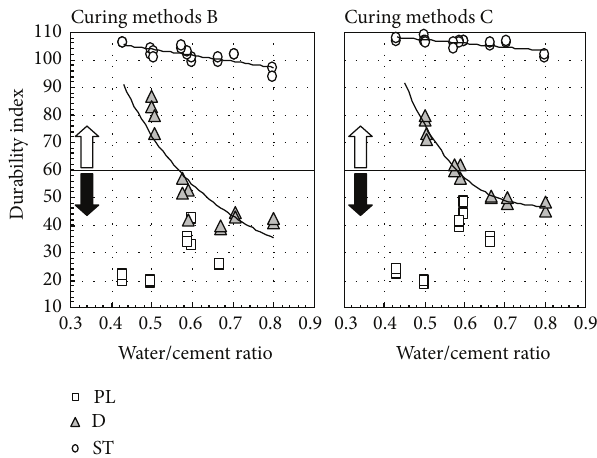
Figure 12: Relationship between water-cement ratio and durability